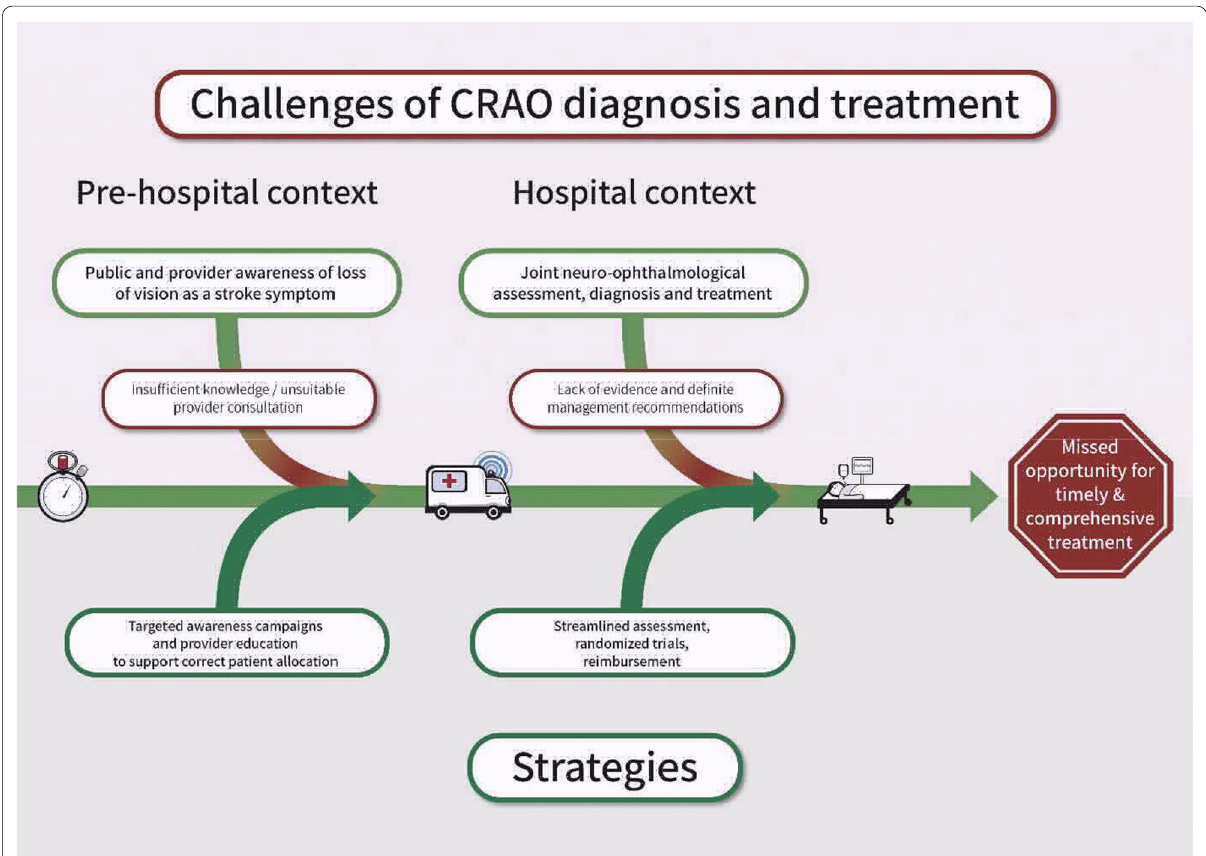
Fig. 2 Ichikawa cause-and-effect diagram of the challenges of diagnosis and treatment in patients with central retinal arterial occlusion and suggested approaches to